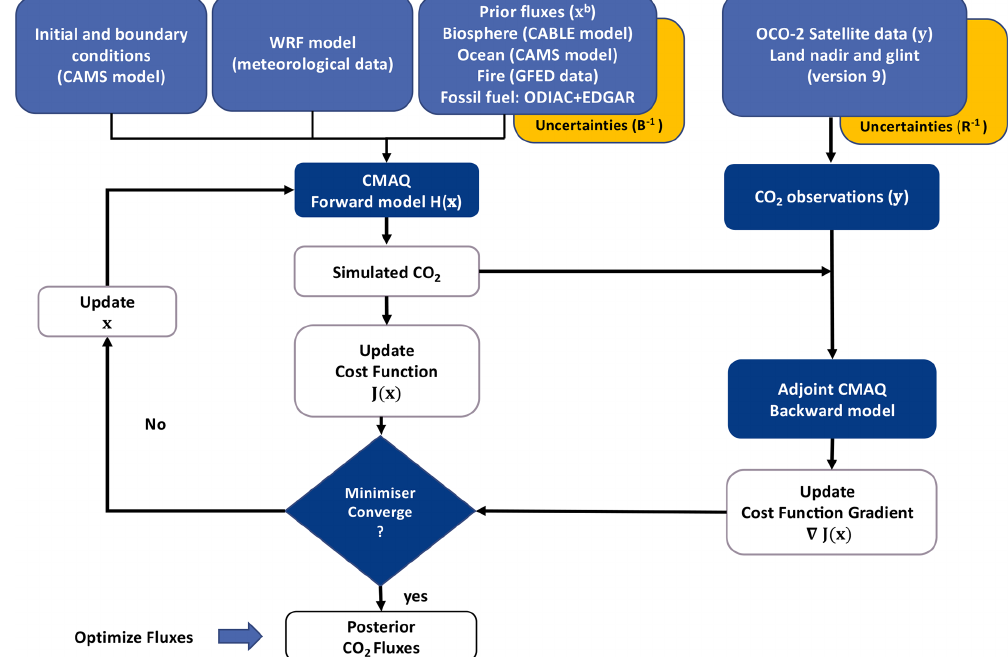
Figure 1. A simplified diagram of the four-dimensional variational data assimilation we used to estimate CO 2 surface fluxes over Australia.